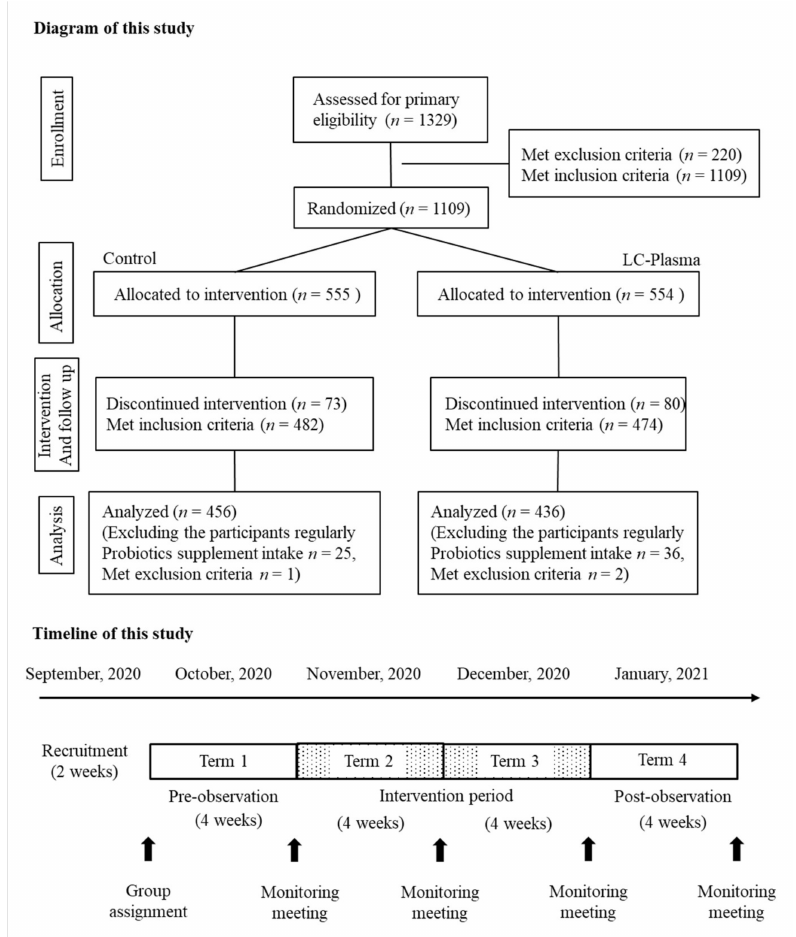
Figure 1. The flow of participants through this study and the